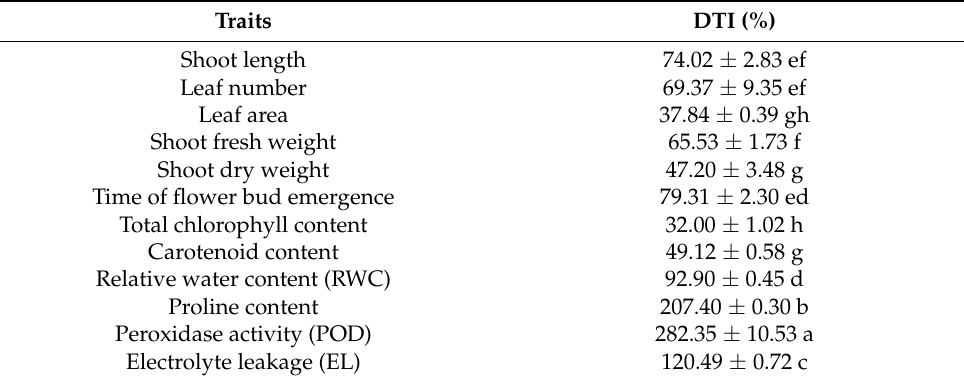
Table 3. Drought tolerance index (DTI%) of all investigated R. asiaticus